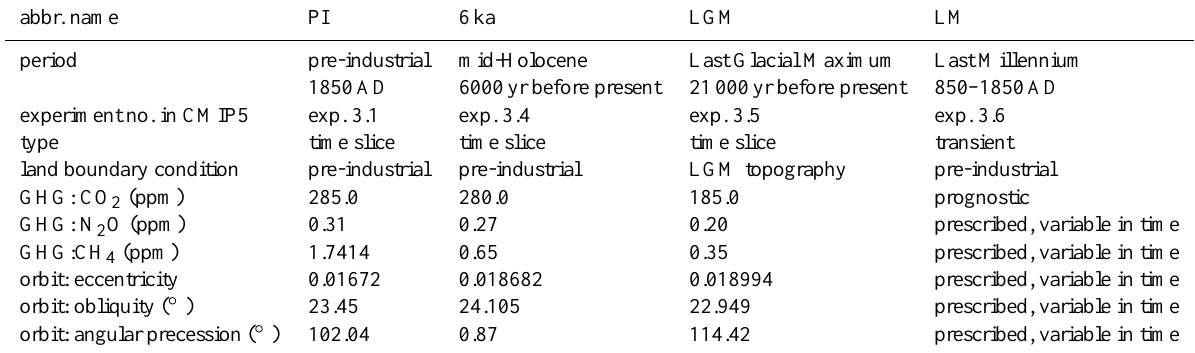
Table 1. The boundary conditions for each